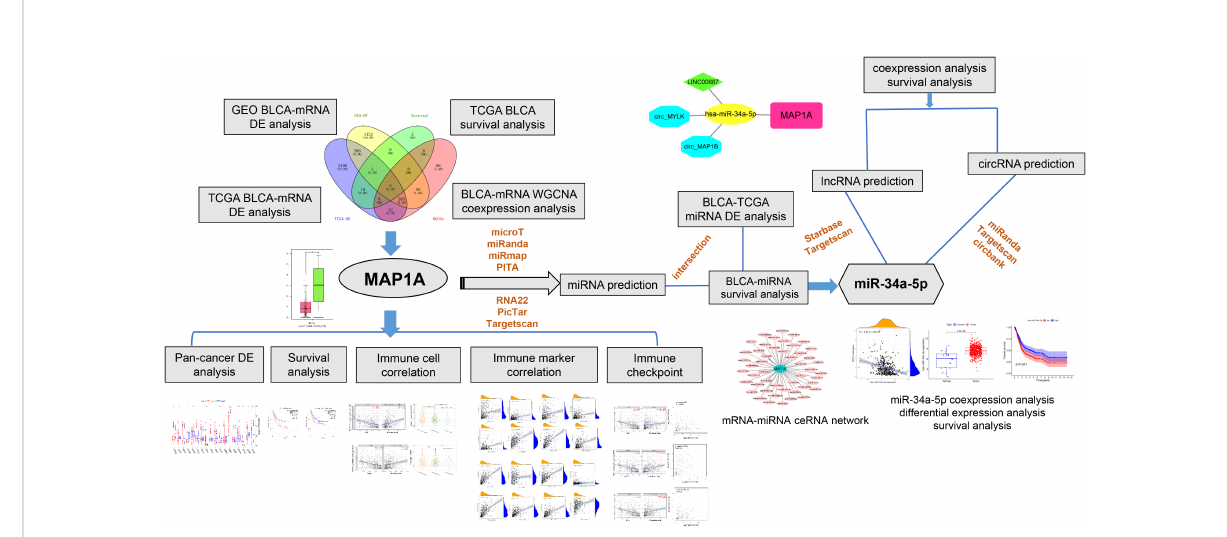
FIGURE 1 Workfolw. We fi rst acquired bladder cancer transcriptome data from the TCGA and GEO databases, and then we performed differential expression, WGCNA, and survival analysis to focus on the research target MAP1A. Then, for the MAP1A gene, we performed pan-cancer analysis, correlation analysis with immune cells and immunological checkpoints, and con fi rmed the MAP1A expression and survival analysis in the GEPIA database. The expression of MAP1A was validated in bladder cancer cell lines. Finally, the mechanism of the MAP1A endogenous competitive RNA network was